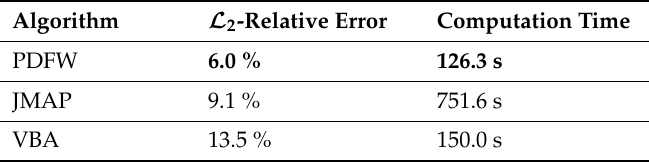
Figure 9. Convergence of VBA Table 2. Comparaison of PDFW, JMAP and VBA